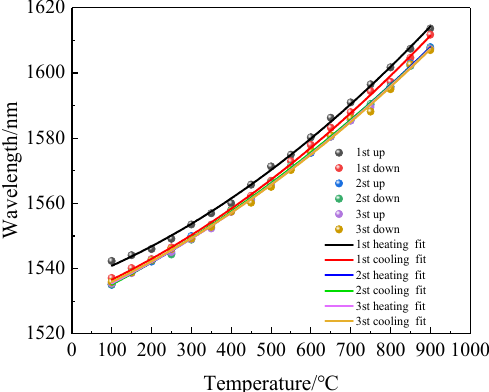
Figure 11. Spectra of the sensor after multiple high-temperature annealing cycles.